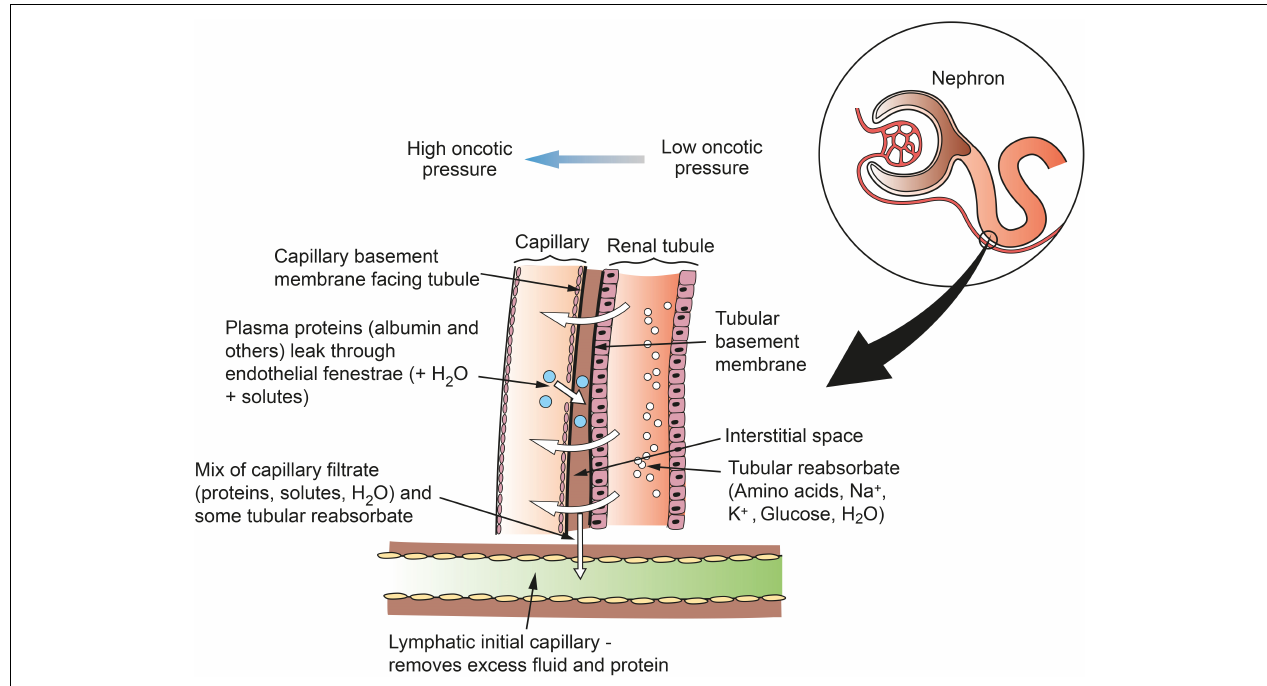
FIGURE 3 | Schematic of flows of reabsorbate from renal tubule to capillary and of protein from capillary to lymph in the renal cortex. Fenestrations on the capillary wall are clustered near narrow interstitial spaces between the capillary and the tubule. Lymph is formed in the interstitial space and taken up into lymphatic capillaries. This mechanism does not apply in the medulla, where lymphatics are sparse and interstitial fluid and macromolecules are taken up into the vasa recta. Figure based on information from Pinter